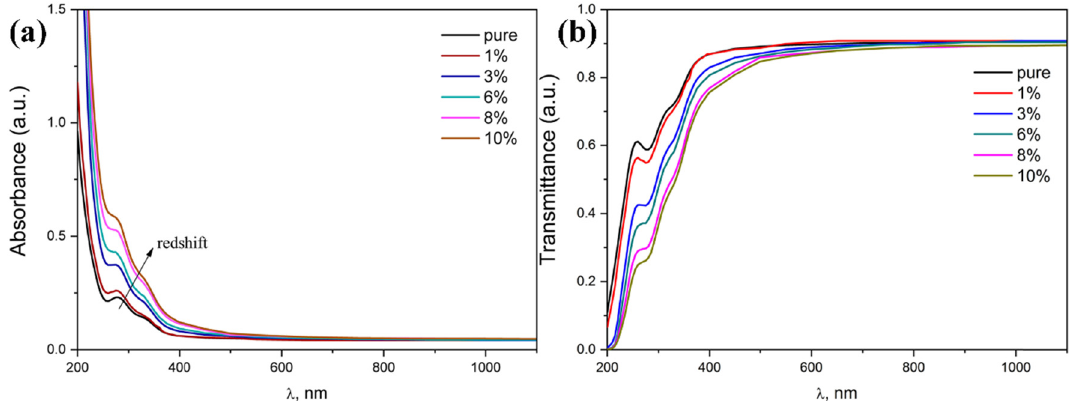
Figure 16: UV - Vis ( a ) absorption spectrum and ( b ) transmission spectrum of PVA/SiO 2 nanocomposite fi lms [ 107 ] ; Copyright: 2020 with permission from